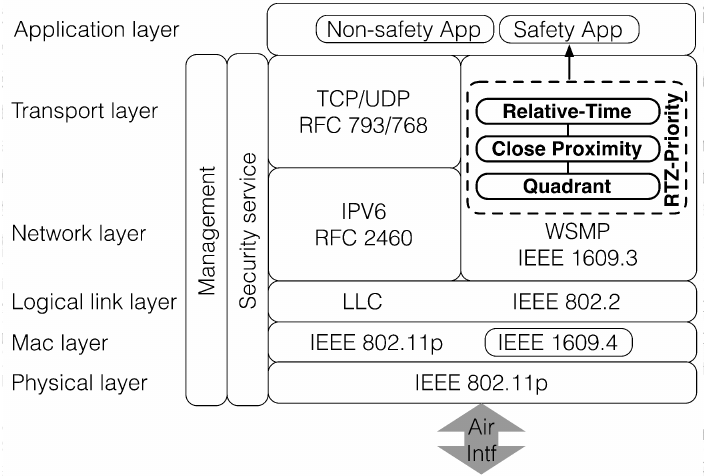
Figure 2. Relative time and zone (RTZ) prioritization scheme in the wireless access in vehicular environment (WAVE) protocol